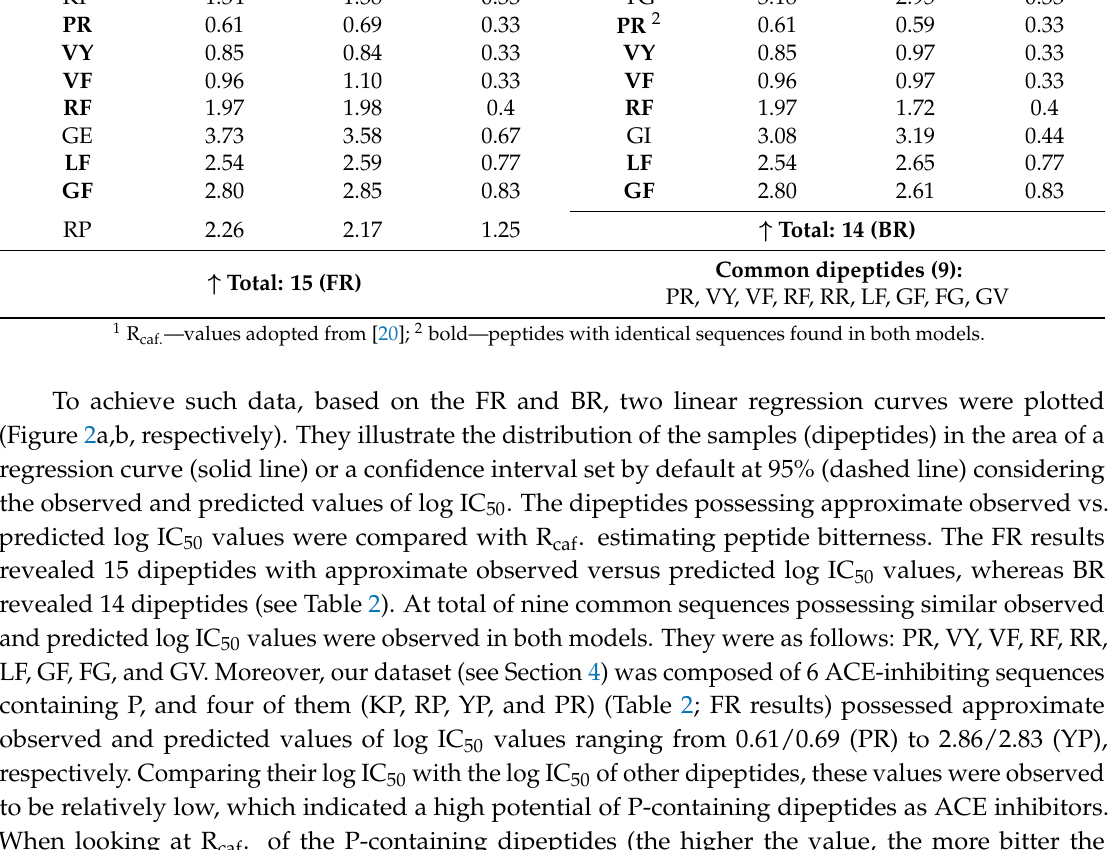
Table 2. ACE-inhibiting and bitter-tasting dipeptides with approximate observed and predicted values of log IC 50 . FR BR Log IC 50 Dipeptides R caf. 1 Peptides Observed Predicted Observed Predicted GR